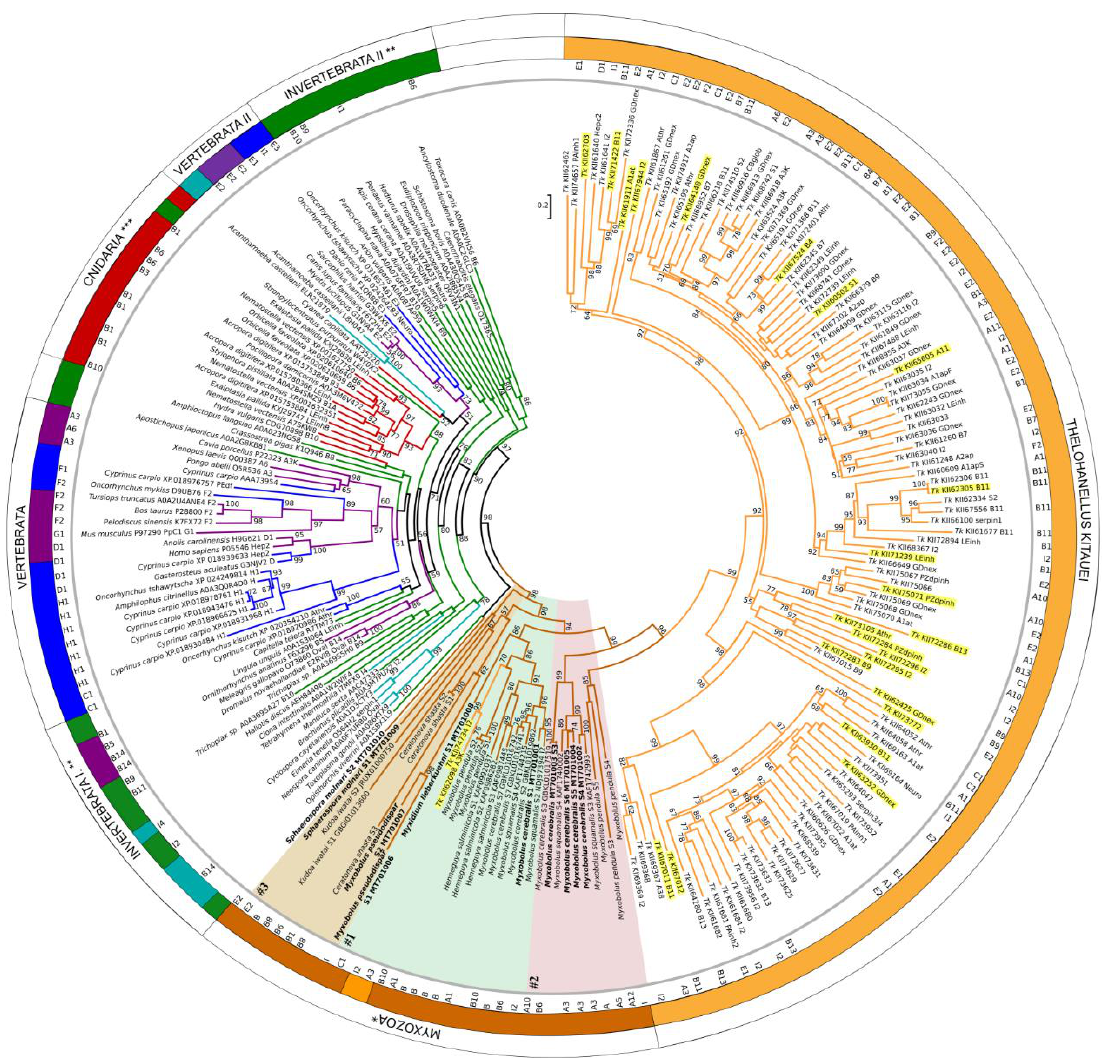
Figure 3. Maximum-likelihood phylogenetic tree inference of serpin genes, based on a 423-aa-long alignment of 224 protein sequences (RAxML, evolutionary model LG + I + Γ 4, 1000 bootstrap replicates). Serpin sequences are represented by species name and GenBank or Uniprot accession numbers. Serpin types, where determined (see Table 1 and Table S1), are indicated in the inner ring. The tree was rooted on the midpoint, and bootstrap values are given as percentages. Tree branches were colored according to taxonomy: vertebrate (purple), fish (blue), protists (turquoise), invertebrate (green), free-living Cnidaria (red), Myxozoa (brown), Thelohanellus kitauei , Tk (orange). * w / o T. kitauei , ** w / o Cnidaria and protists; *** w / o Myxozoa. Myxozoan subclades #1, #2, and #3 were highlighted with background color (#1: green, #2: red, #3: beige). Newly obtained serpin sequences were labelled bold. T. kitauei serpins, which were present in the transcriptome obtained from fish-infecting myxospore, were highlighted yellow.